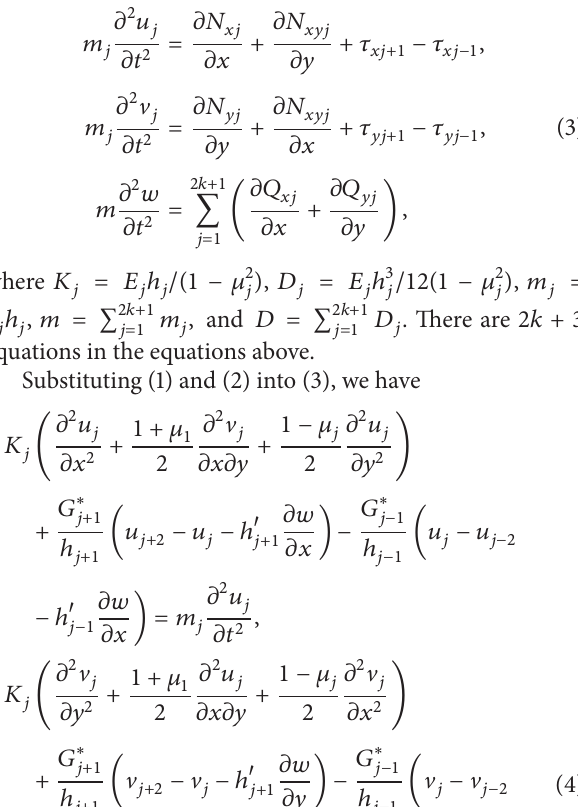
The 1st layer is the host layer, and the 𝑗 th ( 𝑗 = 3, 5, . . . , 2𝑘+ 1 ) layer is the constrained layer. The internal stress can be